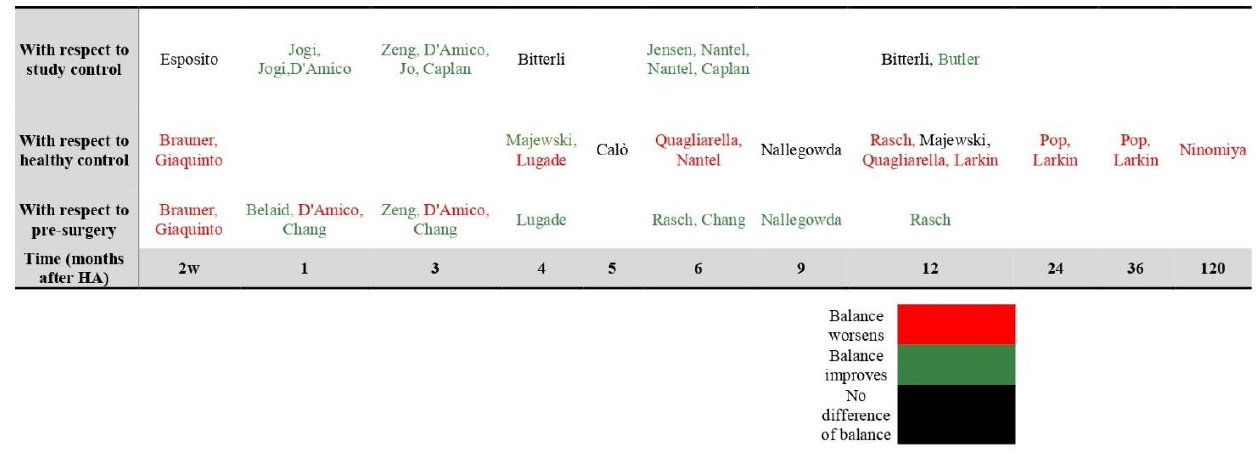
Figure 3. Change in Hip Balance.